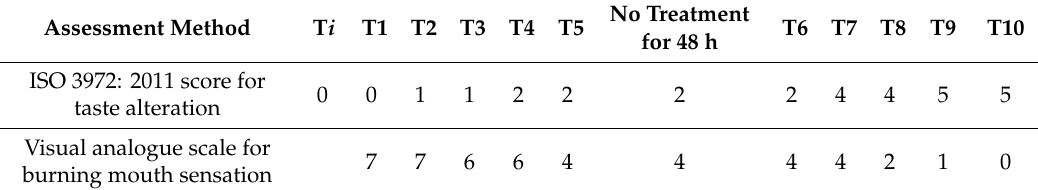
Table 8. Assessment of the quantity of whole resting and stimulated saliva before, during and after treatment (Q-sal, mL / min).